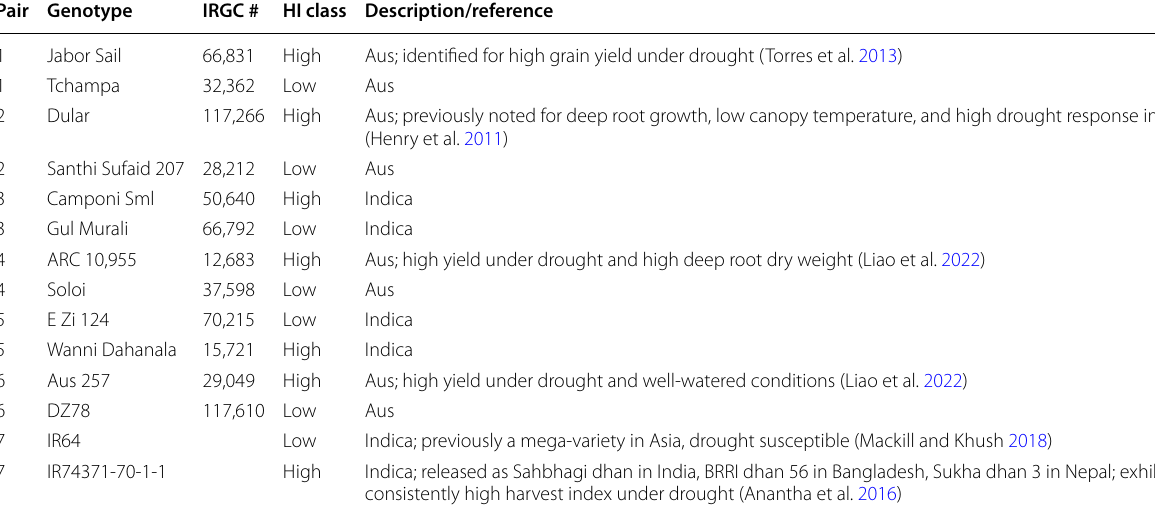
Table 1 Description of the genotype pairs selected for this study with similar shoot biomass and time to flowering but contrasting harvest index Pair